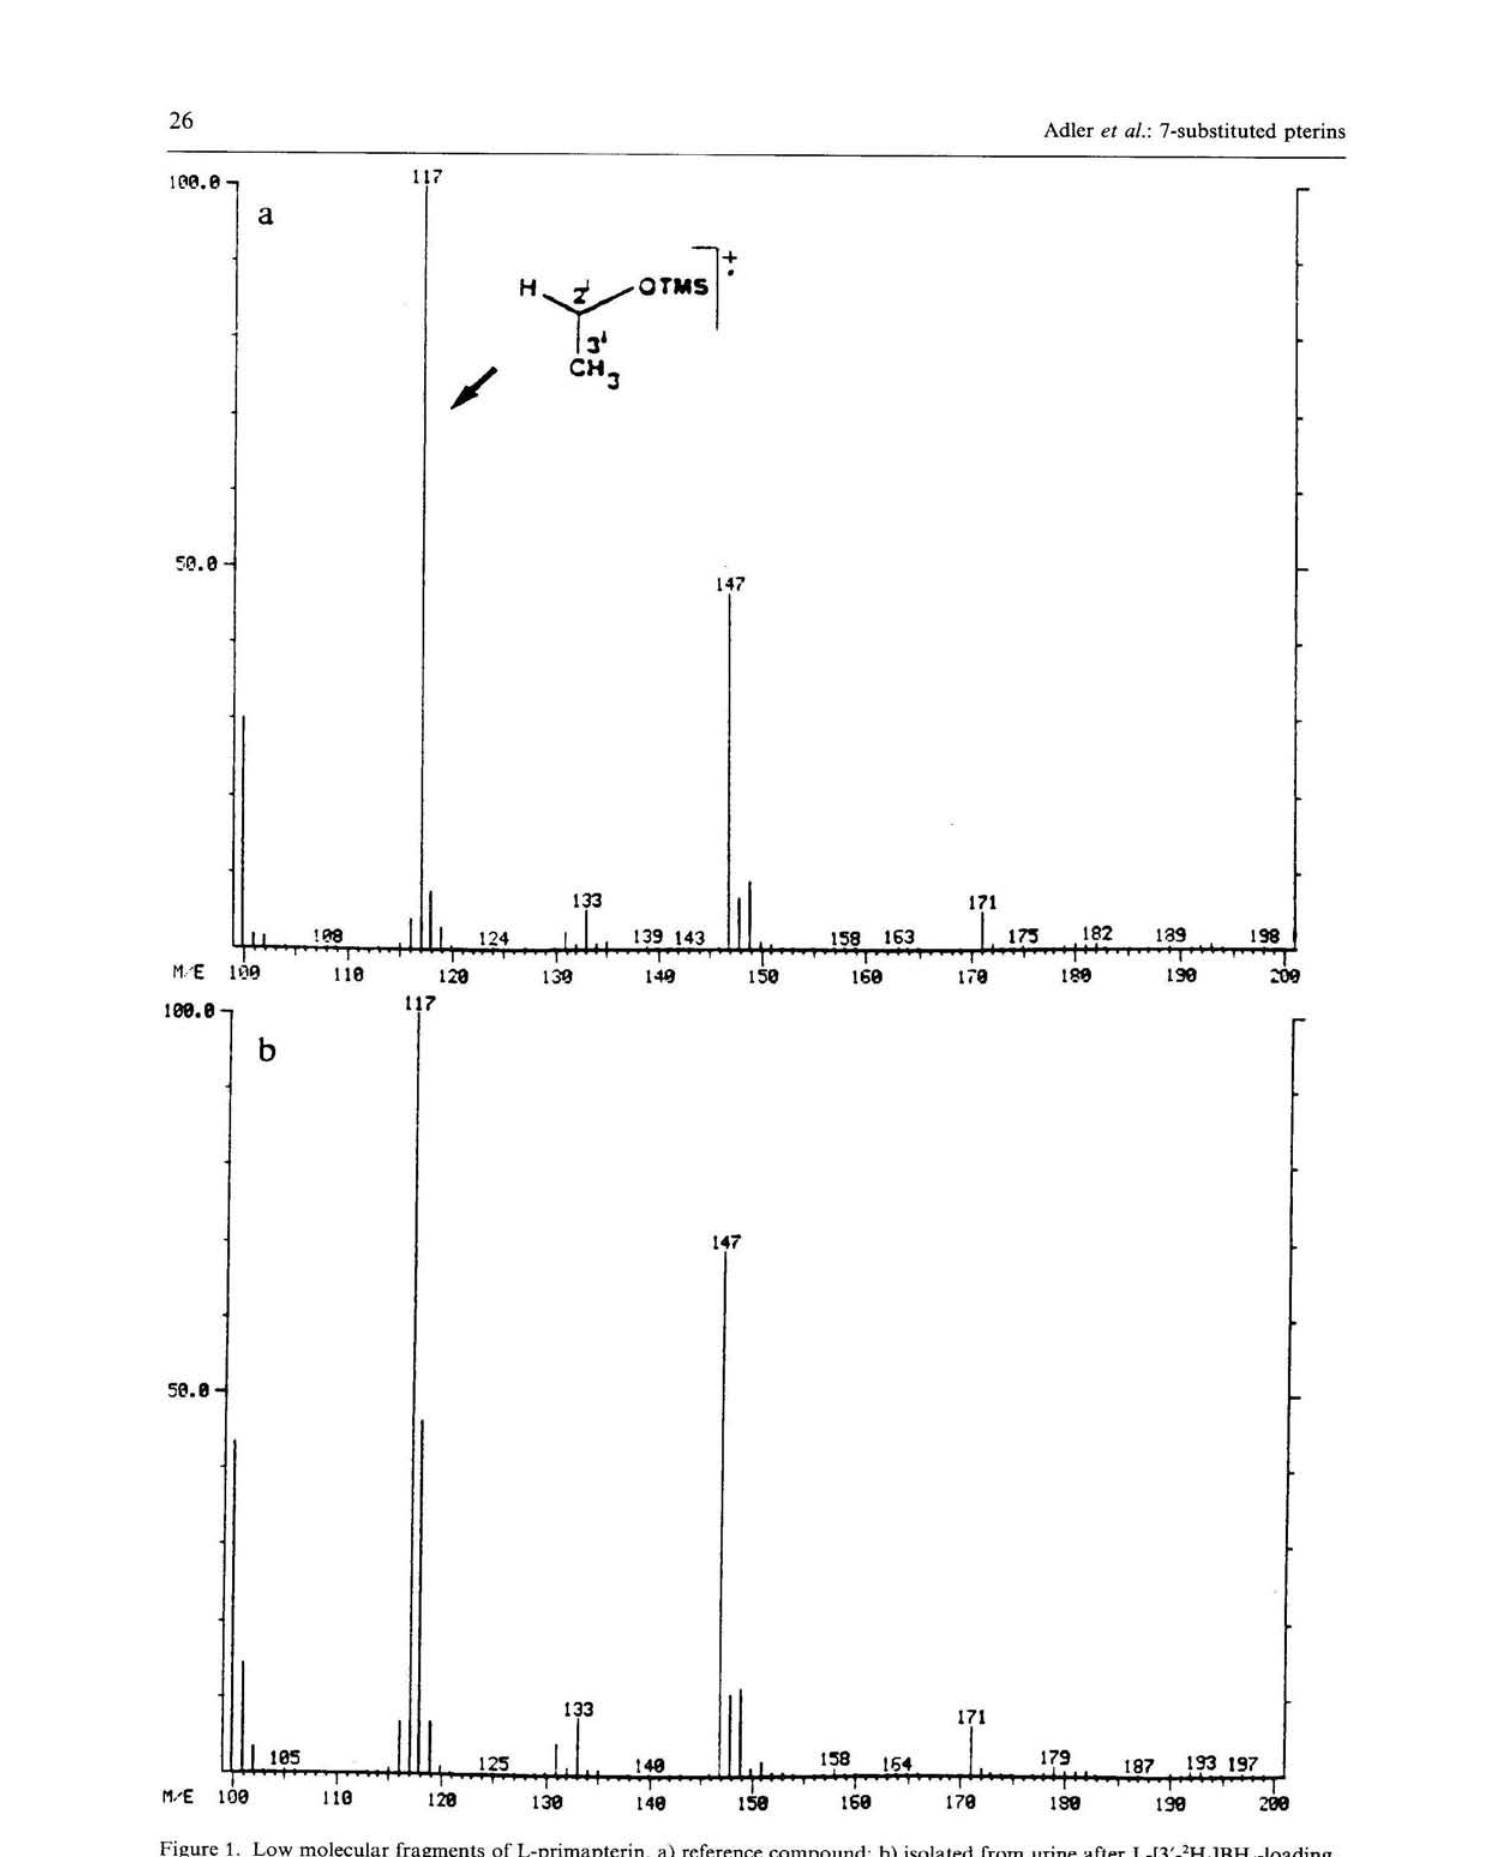
Figure 1. Low molecular fragments of L-primapterin. a) reference compound; b) isolated from urine after L-[3'- 2 H,]BH 4